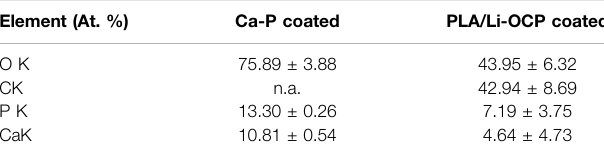
TABLE 1 | Results of EDS obtained from zones Ⅰ and Ⅱ in Figure 1 C,E , respectively. Element (At.